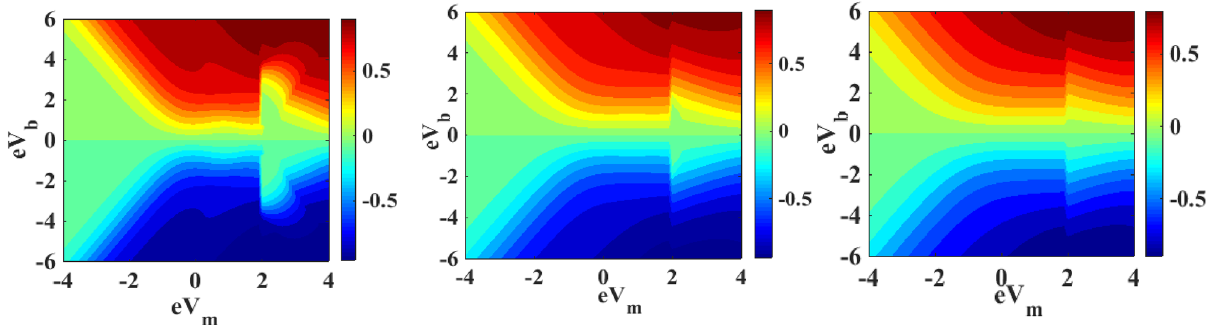
Figure 18. Map of J in the V b − V m — space for (cid:31) = 0.6 and U = 3 for ( a ) k B T = 0.4 ; ( b ) k B T = 0.6 ; ( c ) k B T = 0.8 .